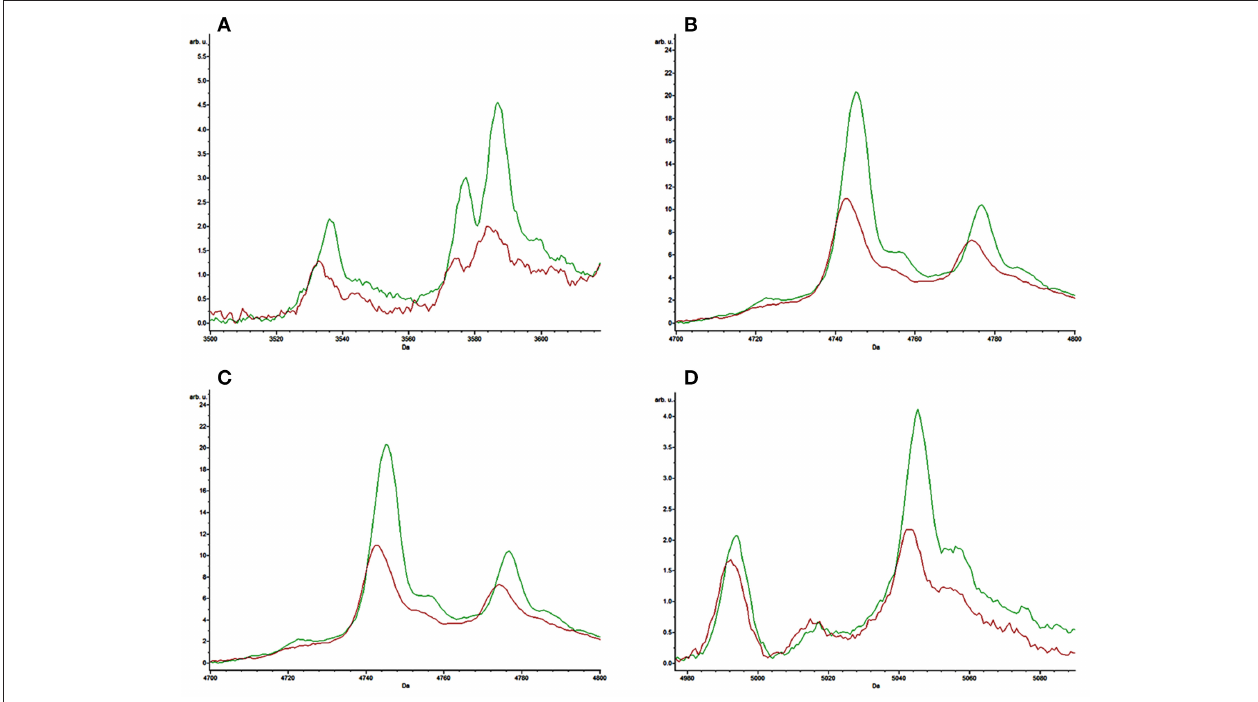
FIGURE 2 | Representative comparison of the average spectra of the K1 hvKP isolates (red) and non-K1 K. pneumoniae isolates (green). (A–D) are the representative spectra of K1 hvKP and non-K1 K. pneumoniae .